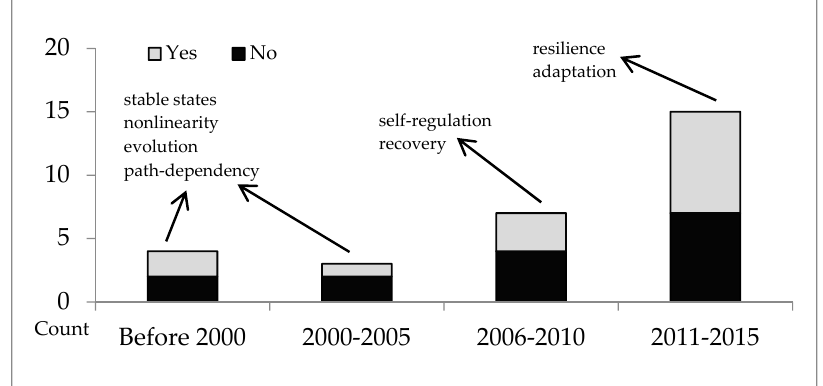
Figure 6. Trend in use of terms related to complex systems to describe land system behaviours. Terms used are connected by arrows to the time period in which their first appearances were found in the reviewed articles.